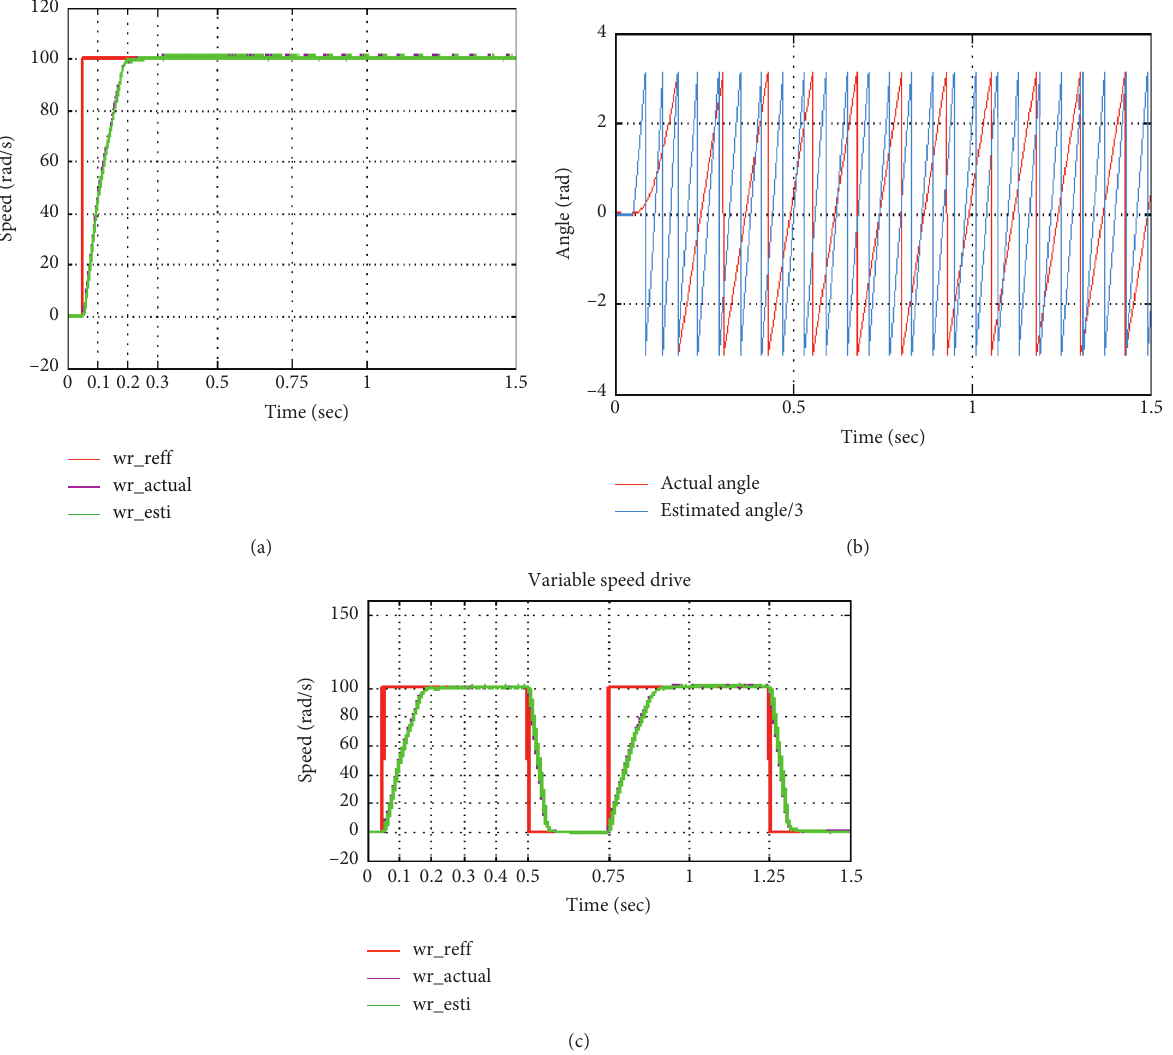
Figure 8: Speed response for square and step reference speed in rad/s and the estimated